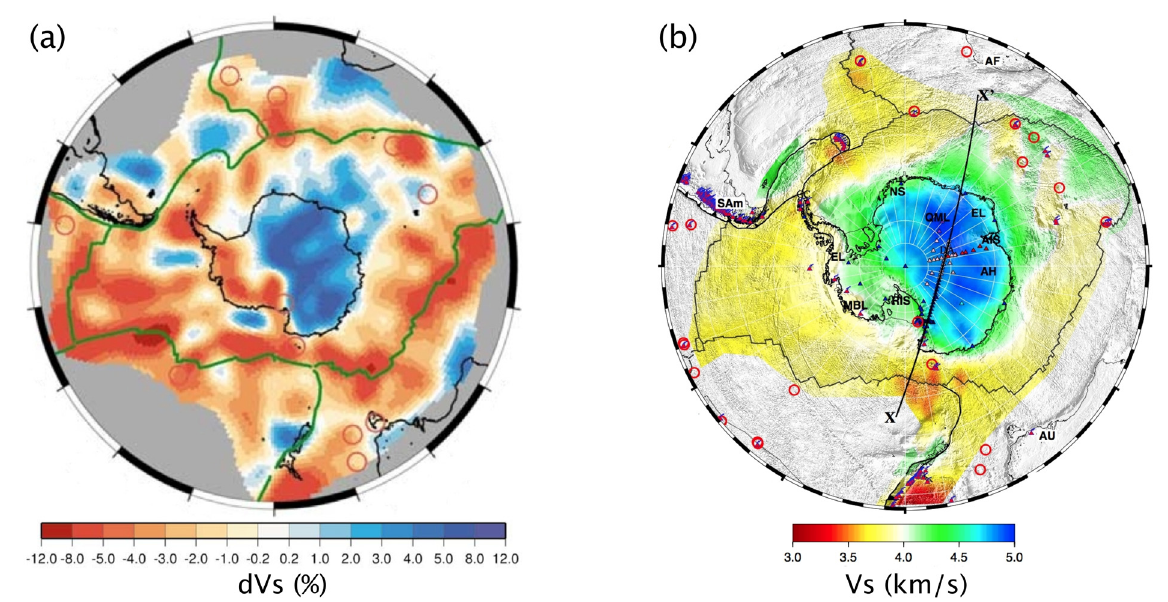
Figure 12. Surface wave tomographic maps of Antarctica at 100-km depth. (a) Results from permanent stations only (after Sieminski et al. [2003]). (b) Preliminary results using permanent and POLENET stations (after An et al.